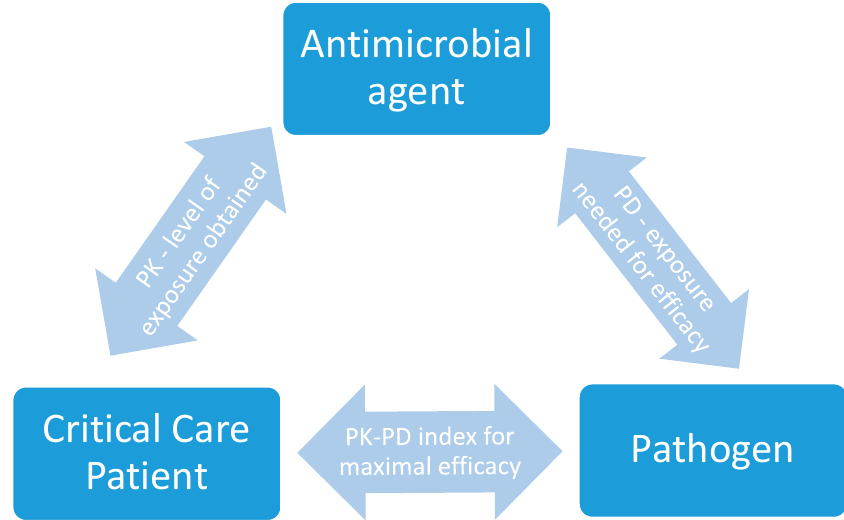
Figure 1. Dynamic interplay between the critical care patient, antimicrobial agent of choice, and the pathogen.